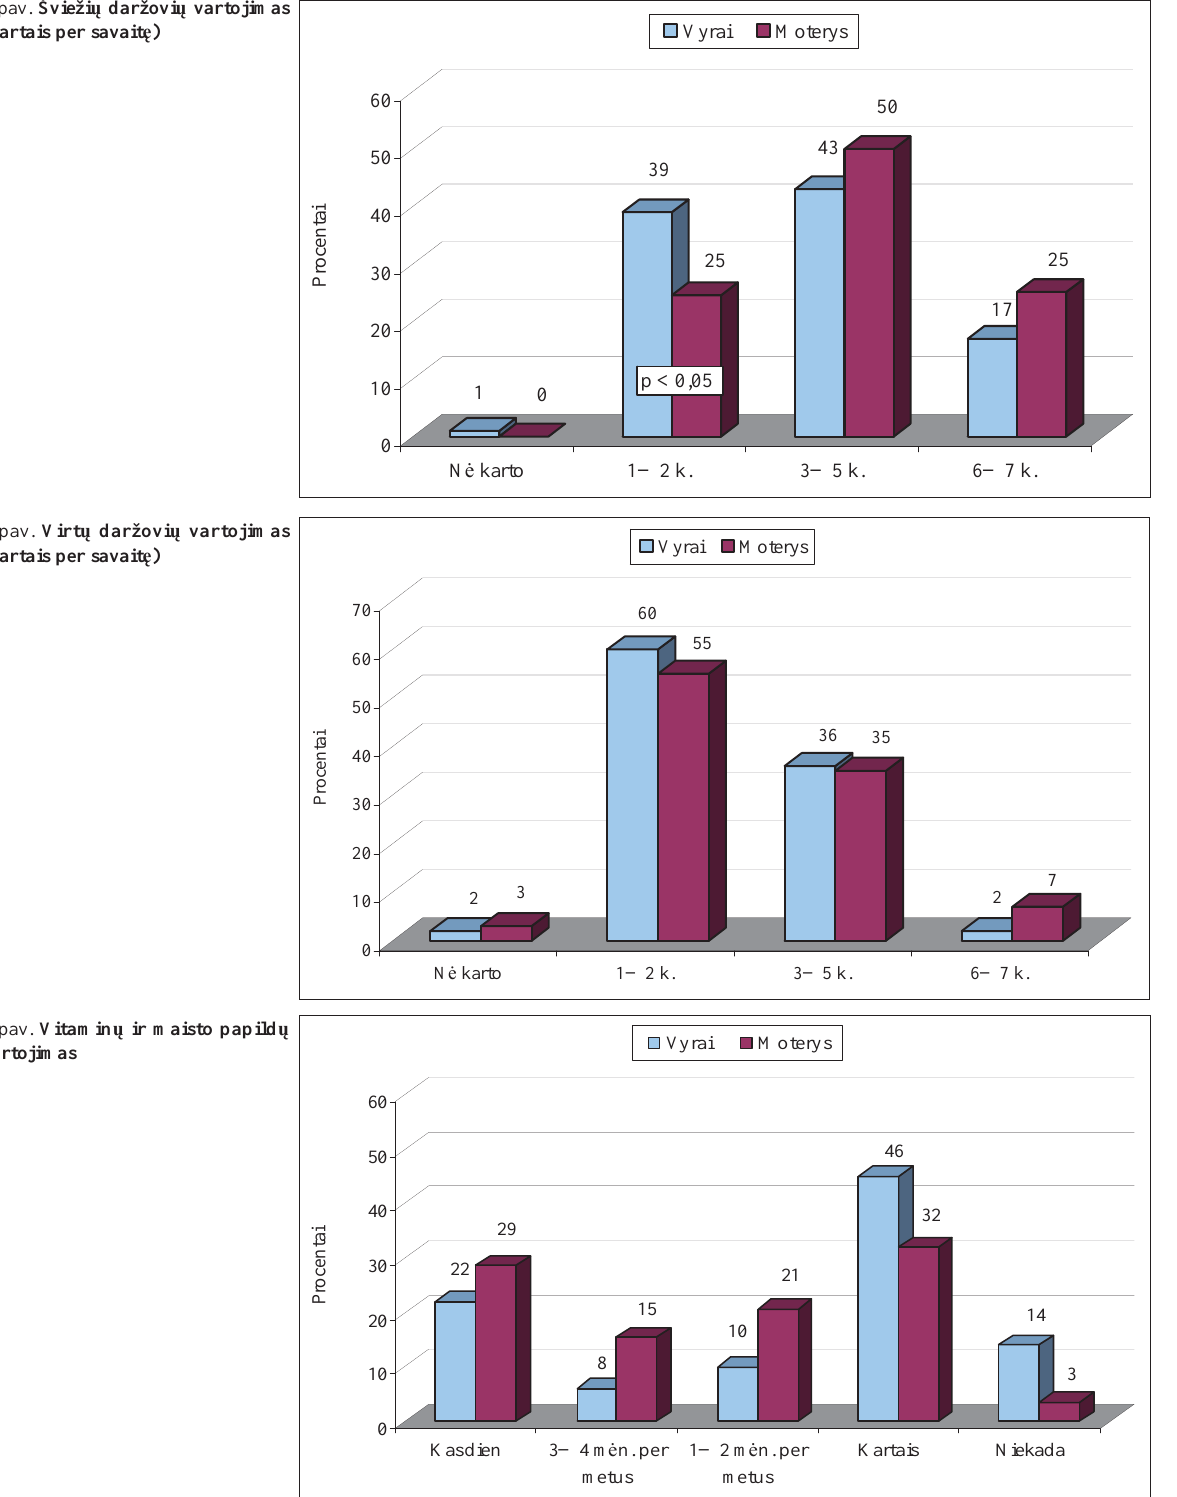
Šviežias daržoves kasdien vartoja 17% k ū no kult ū ros mokytoj ų vyr ų ir 25% moter ų . Statistiškai patikimai daugiau vyr ų (39%) nei moter ų (25%) šviežias daržoves valgo 1—2 kartus per savait ę .